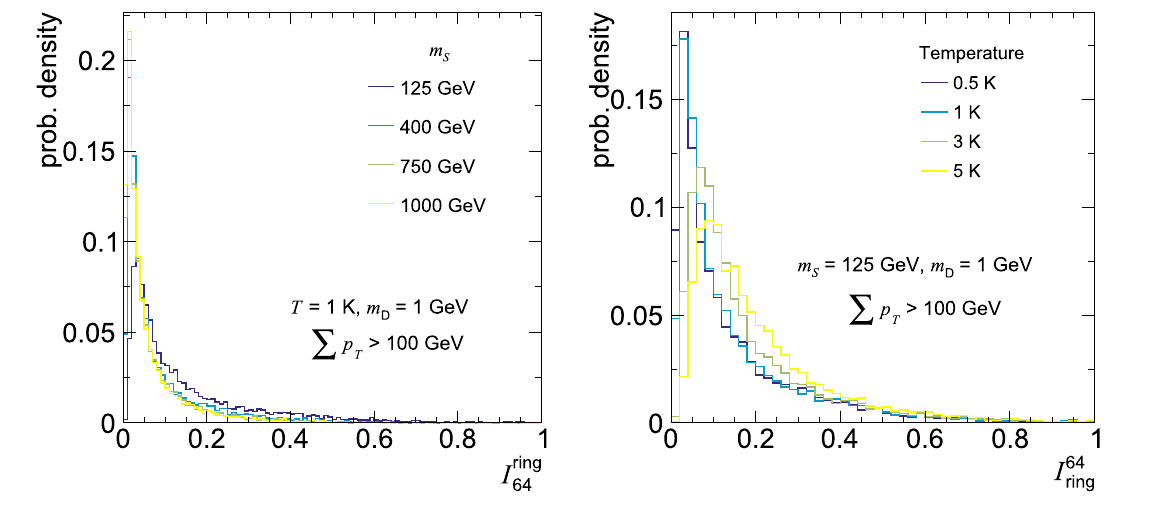
in quasi-isotropic radiation patterns. For reference, we also include the correlation plot of the same samples in thrust and maximum eigenvalue (bottom right). The contours enclose 99% of the events for all of the samples. Figures adapted from